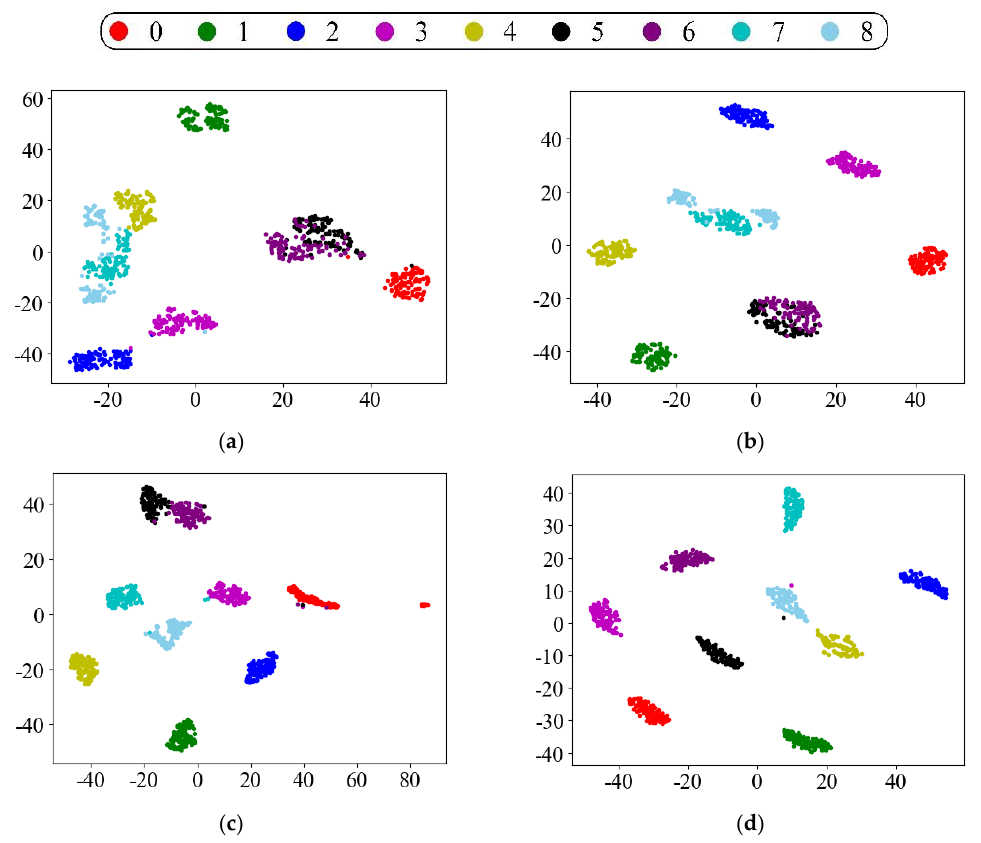
Figure 13. Visualization comparison of each method’s fault characteristics in Task C → A. ( a ) CNN; ( b ) CNN + MMD; ( c ) ResNet; ( d ) proposed method.